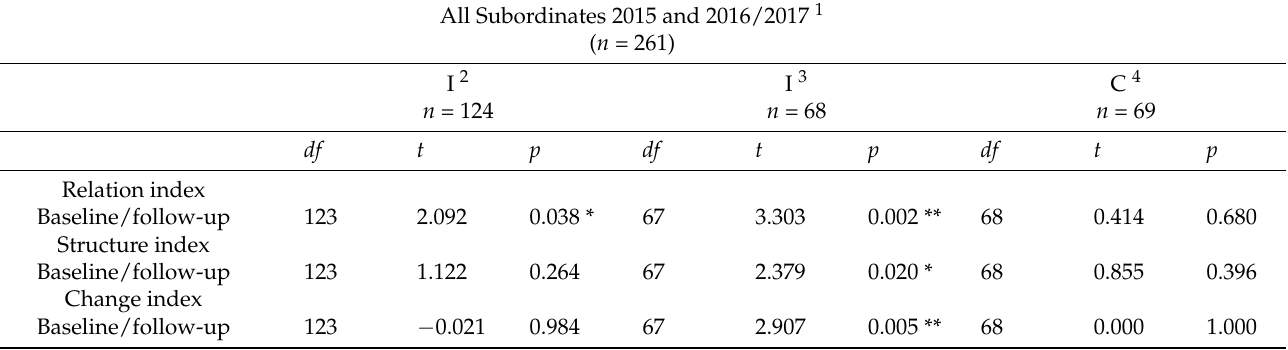
Table 5. Paired samples t-tests for the baseline and follow-up regarding relation, structure, and change indexes for subordinates in 2015 and 2016/2017, n =